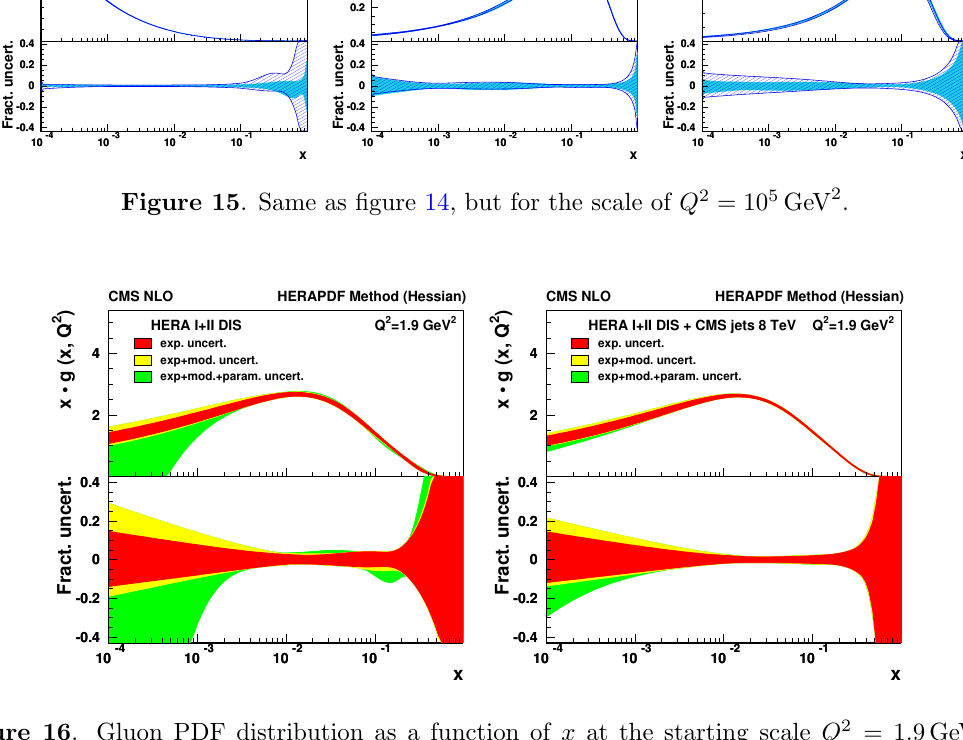
Figure 16 . Gluon PDF distribution as a function of x at the starting scale Q 2 = 1 : 9 GeV 2 as derived from HERA inclusive DIS (left) and in combination with CMS inclusive jet data (right). Di(cid:11)erent contributions to the PDF uncertainty are represented by bands of di(cid:11)erent shades. In the bottom panels the fractional uncertainties are